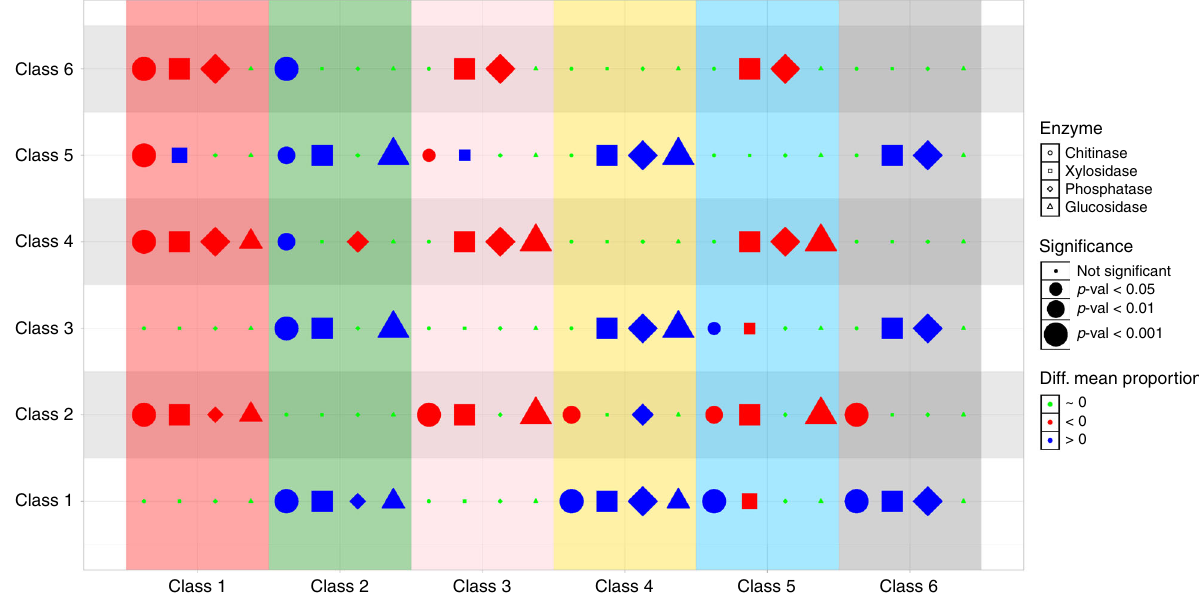
Fig. 4 Summary of post hoc analysis of exo-enzymatic genes predictions. The signi fi cance of differences in mean proportions of chitinase (circles), β -xylosidase (squares), β -glucosidase (triangles) and phosphatase (diamonds) were tested across all pairwise combinations of community classes. Red (blue) symbols denote that the class in the correspondent column has a signi fi cantly lower (higher) mean proportion of the enzyme than the class shown in the row. The size of the symbol is larger for more signi fi cant differences. All tests are provided in Supplementary Fig.